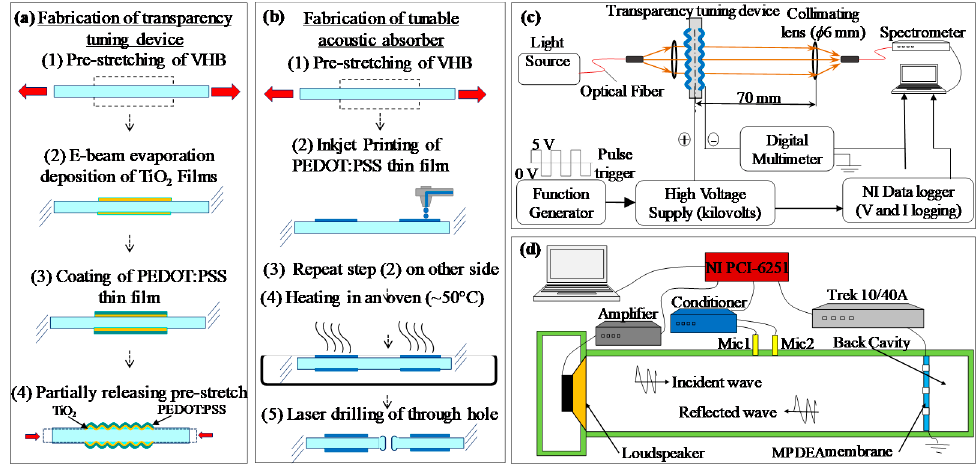
Figure 2. Fabrication procedure of the ( a ) transparency tuning device; ( b ) tunable acoustic absorber; measurement setup at various activation voltage for ( c ) optical inline transmittance measurement; ( d ) normal acoustic absorption.